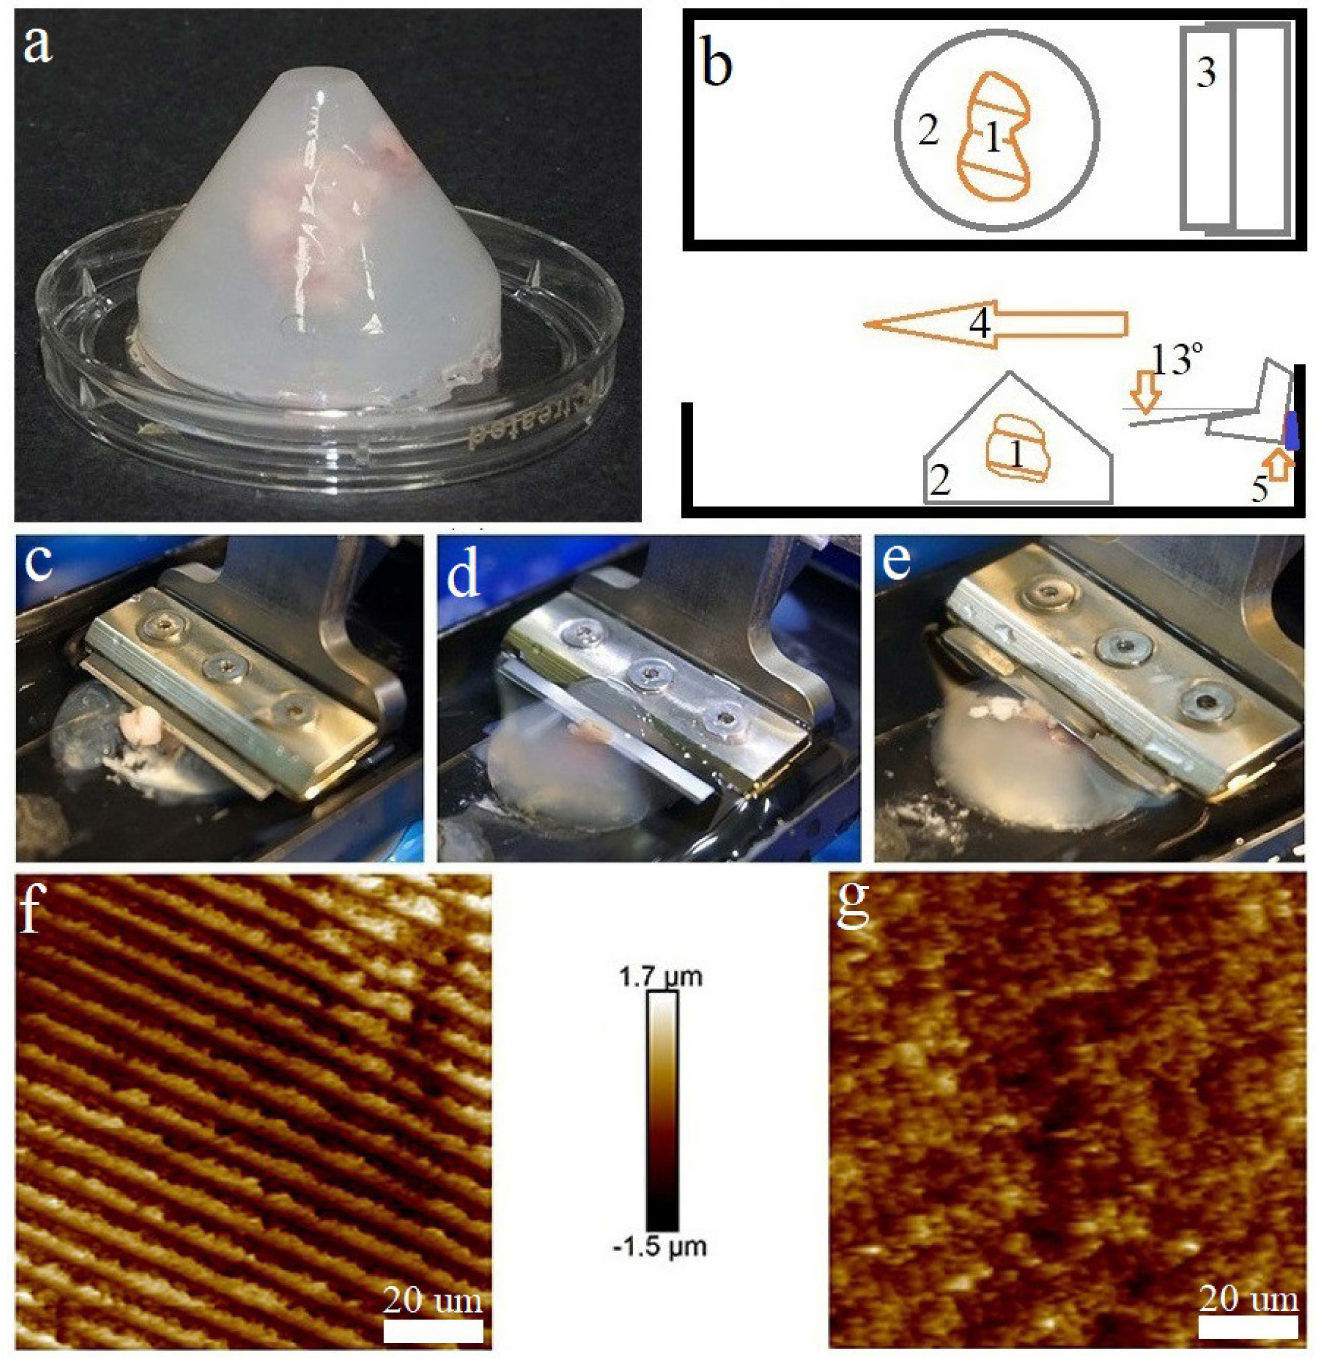
Figure 2. Vibrosectioning of the rat brain embedded in the matrix cone ( a – e ): ( a ) brain specimen embedded in the matrix cone; ( b ) schematic representation of the vibratome components adjusted for live brain sectioning: (1—specimen of brain, 2—embedding matrix cone, 3—vibratome blade, 4—vibratome blade translation, 5—gasket/spacer); ( c ) Vibrosectioning of the rat brain in the embed- ding matrix with insufficient stiffness (<2.500 µ N/m) and elasticity (<27 kPa); ( d ) Vibrosectioning of the rat brain in the embedding matrix with suitable stiffness (2.6 µ N/m) and elasticity (27 kPa); ( e ) Vibrosectioning of the rat brain in the embedding matrix with excessive stiffness (>3.5 µ N/m) and elasticity (>30 kPa); ( f , g ) slice quality control by AFM with ScanAsyst Fluid High Resolution tip (Height sensor channel): ( f ) the slice surface of an agar gel (2.5% agar) without collagen (Height sensor channel); ( g ) the slice surface of collagen–agar gel (2.0% agar; 0.5 mg/mL type I